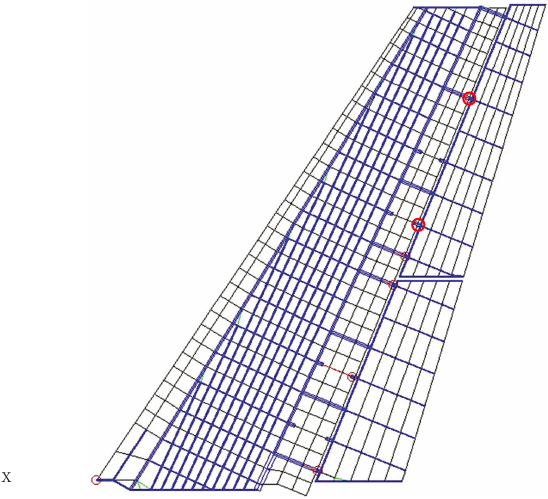
Figure 13: Wing-aileron connection in Case 3. Table 3: Comparison of aileron e ff ectiveness. Cases